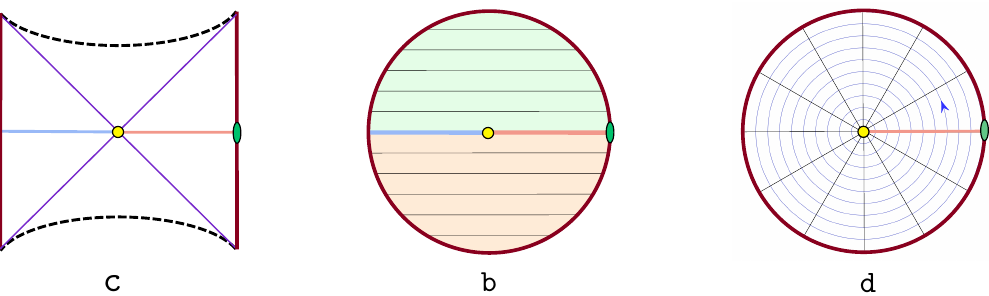
Figure 17 . AdS-Schwarzschild analogs of c,b,d in figure 14. Black dotted line = singularity. Thick brown line = conformal